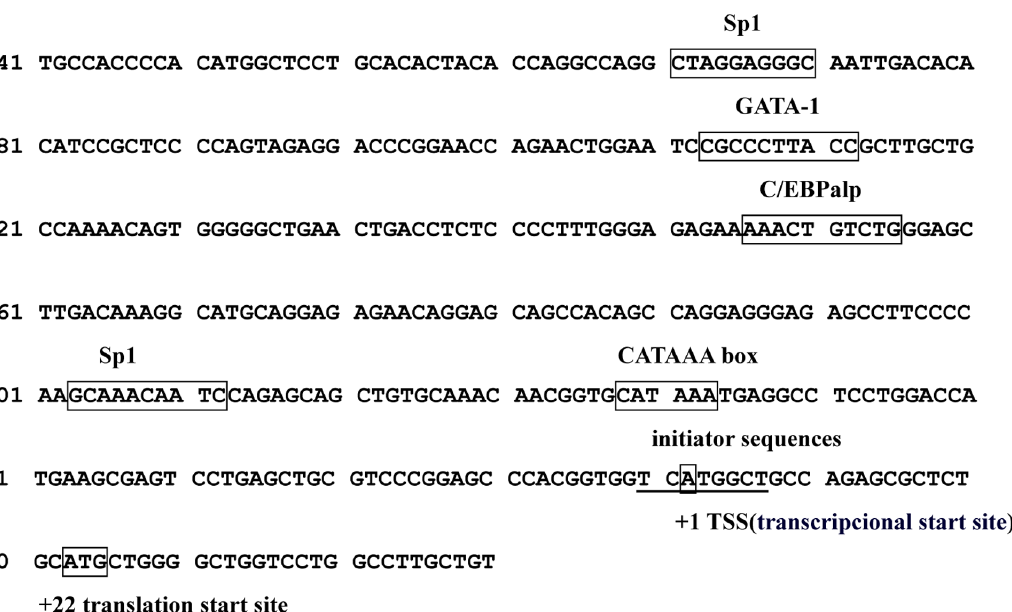
Figure 1. Nucleotide sequence of the hTFF3 gene core promoter region. The numbering of the sequence is relative to the TSS. Putative binding sites for the transcriptional factors are boxed and labeled above.